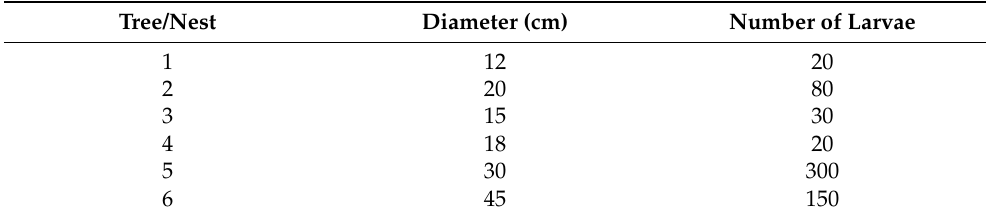
Table 1. Traits of the pine processionary moth nests collected from the felled trees.